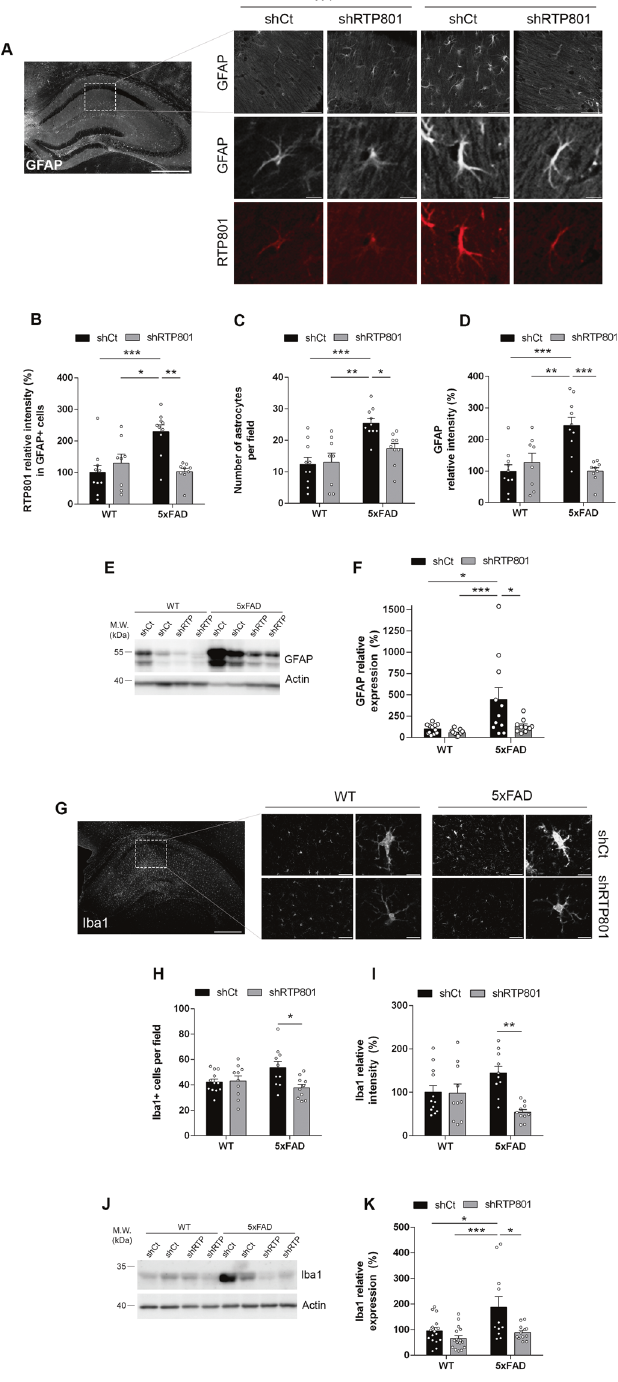
observed by western blot evaluating total GFAP levels in the entire dorsal hippocampus (Fig. 5E, F) strengthening the idea that normalization of RTP801 levels in hippocampal principal neurons restores and ameliorates the astrogliosis processes associated with the 5xFAD mutations. To further gain insight into the neuroin fl ammatory processes mediated by RTP801 in the 5xFAD mice, we then evaluated microglial processes in the same animals. Microgliosis or changes in microglial states have been described in neurodegenerative disorders such as AD [41]. To do so, we fi rst assessed the number